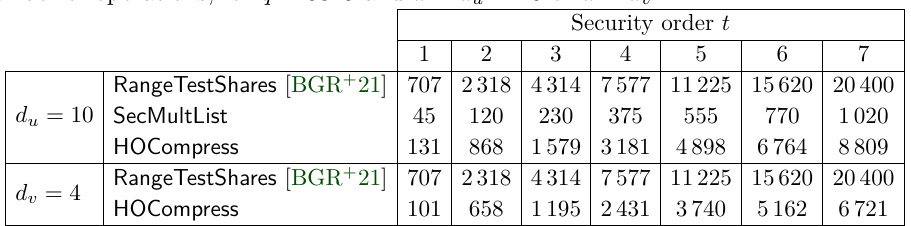
Table 8: Comparison of the RangeTestShares , SecMultList and HOCompress algorithms, in number of operations, for q = 3329 and d = d u = 10 or d = d v = 4.